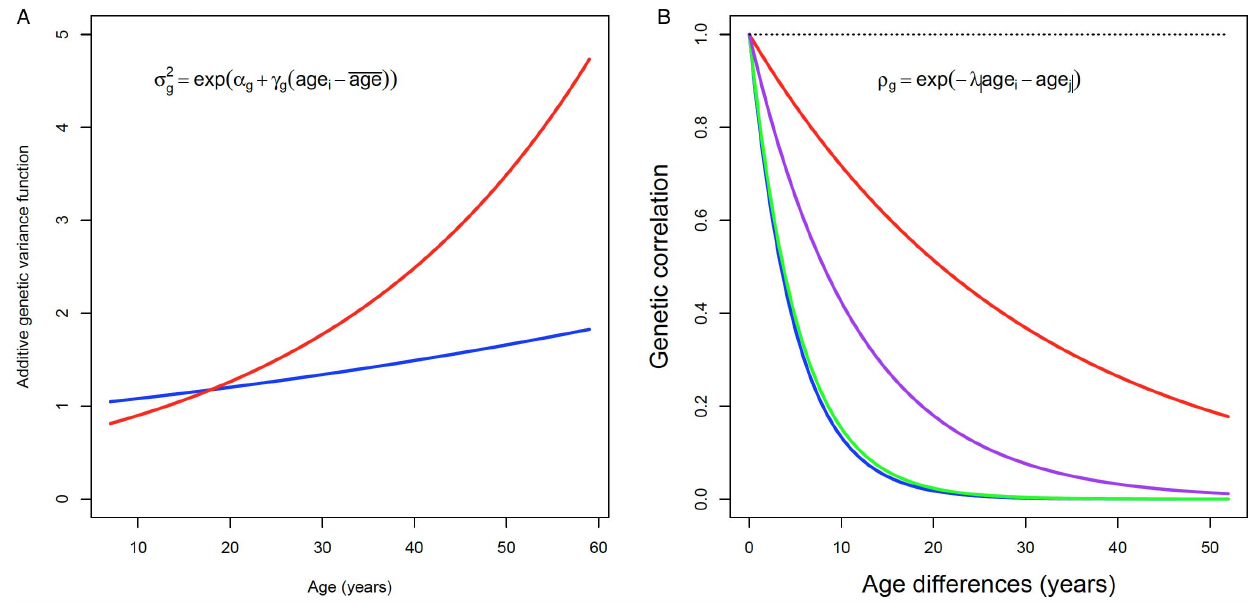
Figure 1. Genotype X Age genetic variance (a) and Genotype X Age genetic correlation (b). Legend: Blue – PC; Red – Sed; Green – EE; Purple – PA tertiles.